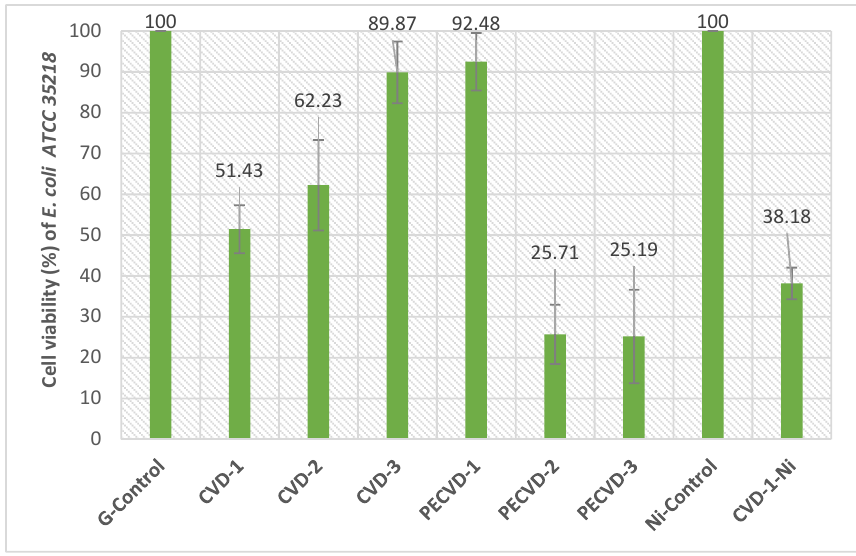
Figure 7. Cell viability (%) of Escherichia coli ATCC 35218 .